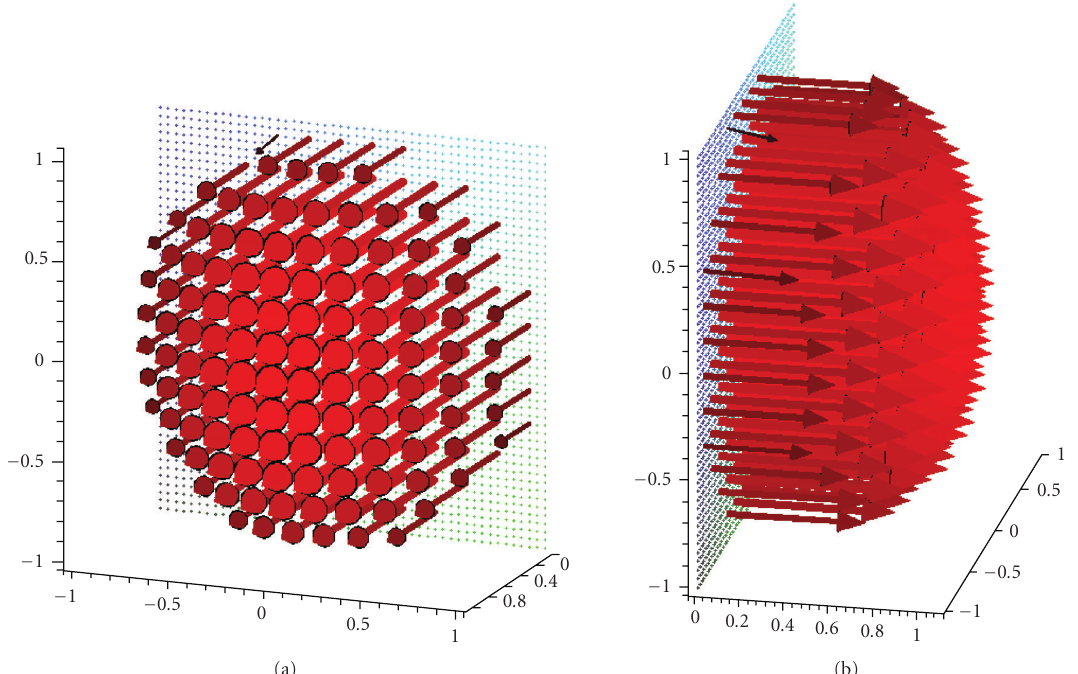
Figure 12: Reconstruction of the vector field f ( x ) = (1,0,0) (cid:9) with the described algorithm for γ = 0 . 0075 in the plane { x 1 = 0 }